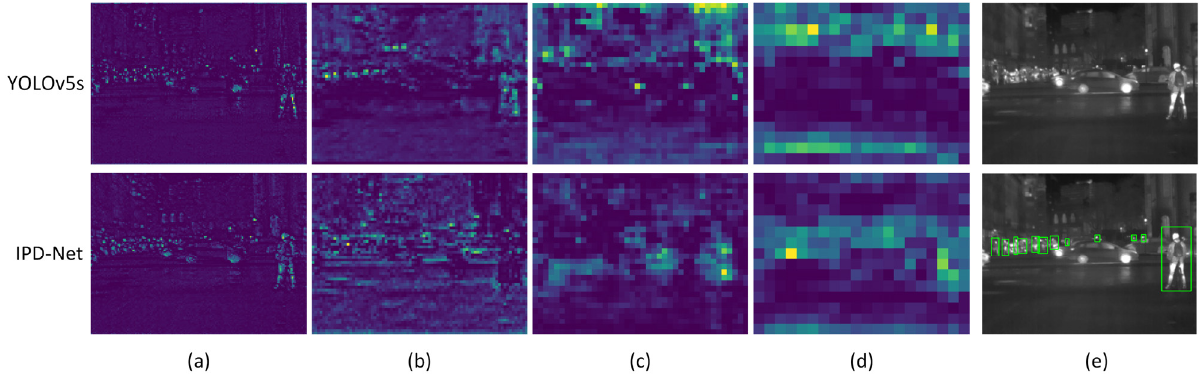
Figure 11. Visualization of the feature heat maps extracted from the backbone networks of IPD-Net and YOLOv5s: ( a – d ) represent the feature heat maps of the C2, C3, C4, and C5 layers of the backbone networks, respectively; ( e ) shows the original image and ground truth, and green boxes represent pedestrians annotated in the dataset.